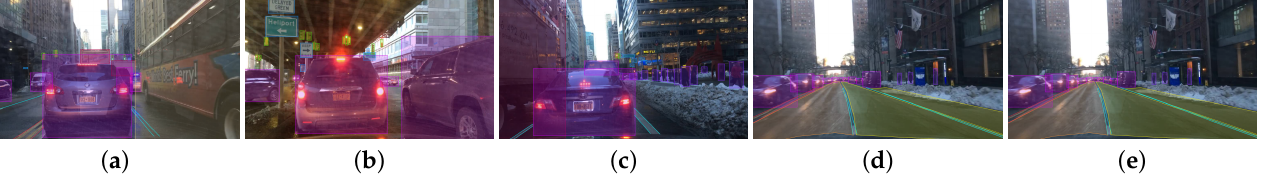
Figure 18. Visualization results of ELECTRICITY tracking algorithm on BDD100K data set, where ( a – e ) are the results of vehicle detection and tracking in the same scene in the same video.